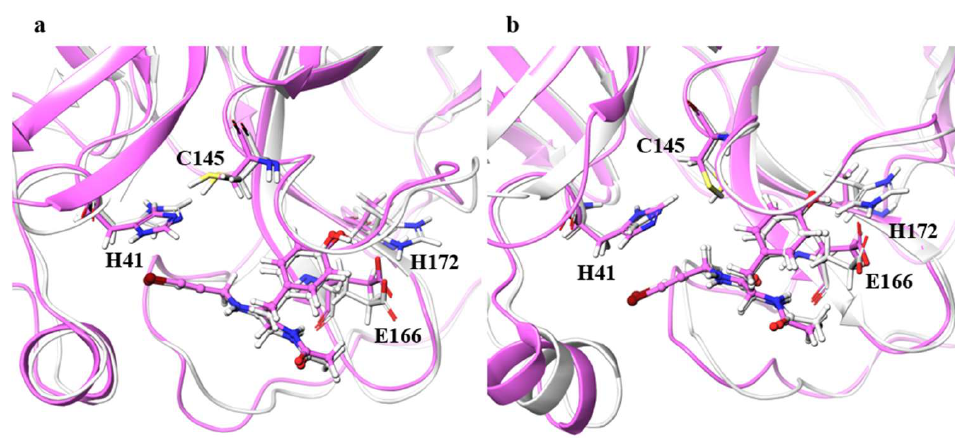
Figure 4. Structures around the ligand in the ( a ) A and ( b ) B chains. Atoms and chains of wild type and H172A are presented in white and magenta, respectively. The ligand is represented by the ball-and-stick model, and H41, C145, E166, and H172 are represented by the stick model.